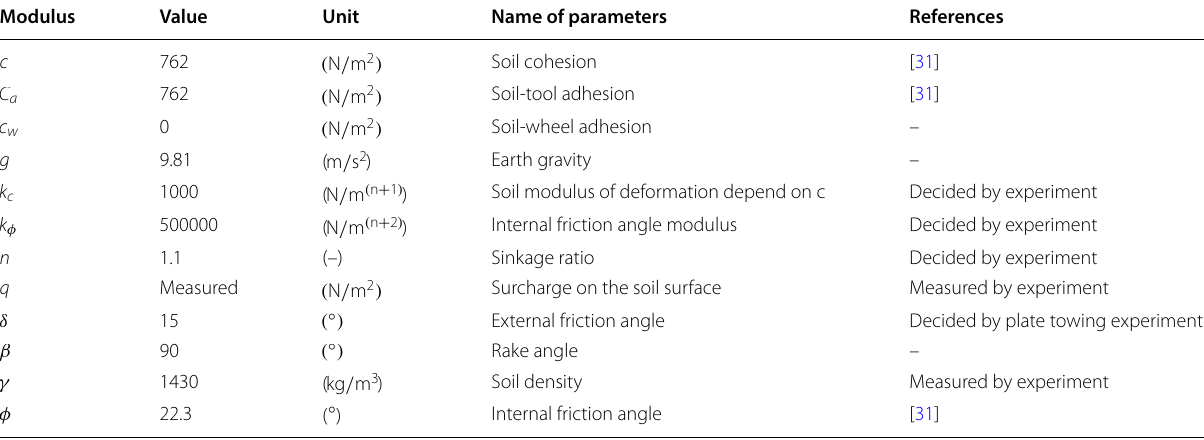
Table 3 Soil parameters and values for the calculation of the wheel